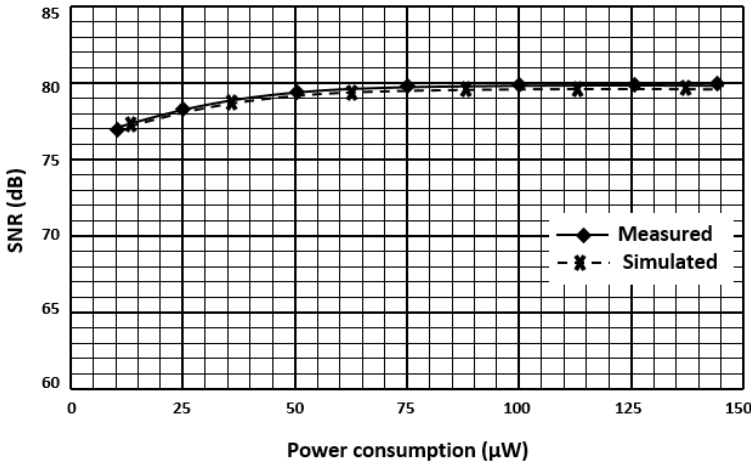
Figure 8. Signal-to-noise ratio (SNR) of the proposed chopper negative-R stabilization preamplifier versus power consumption.